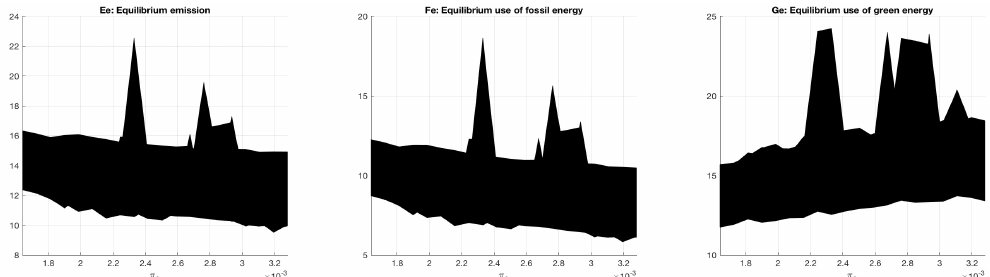
Figure A8. e , f and g for non-OECD countries.